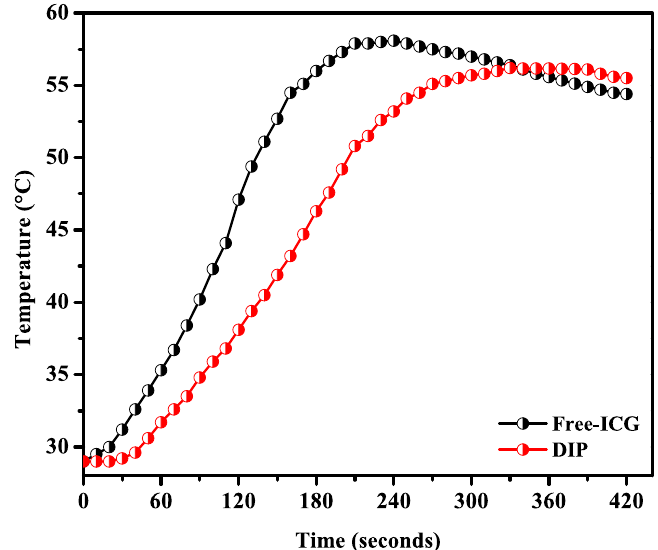
Figure 12. NIR Hyperthermia of Free-ICG and DIP proniosomal gel-derived